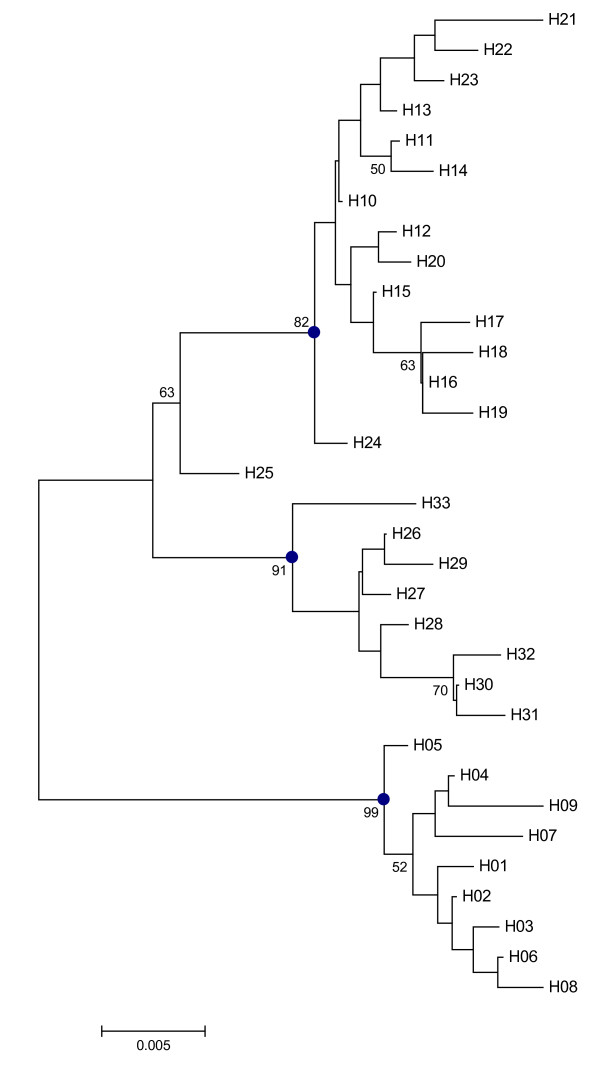
The NJ phylogeny tree of the haplotypes used to calculate the dN/dS (ω) ratio for each site.